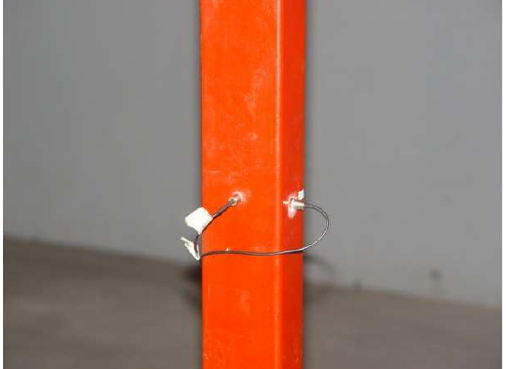
Figure 2. Accelerometers installed on the prototype prism at mid-span.